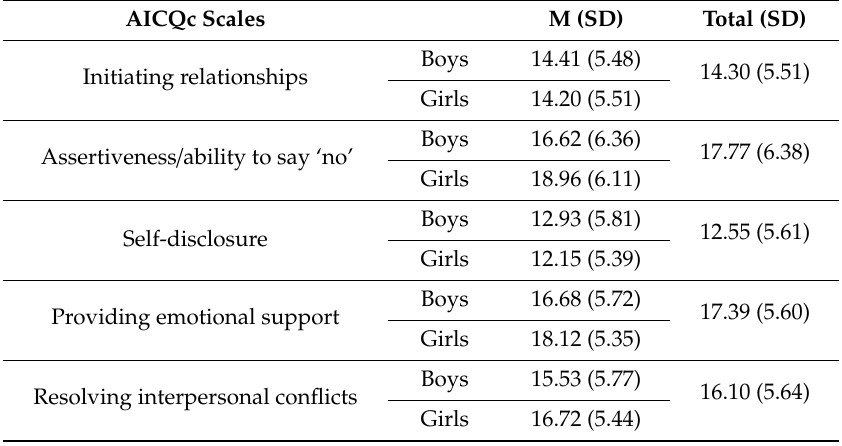
Table 3. Mean Scores and Standard Deviation by gender in the competency